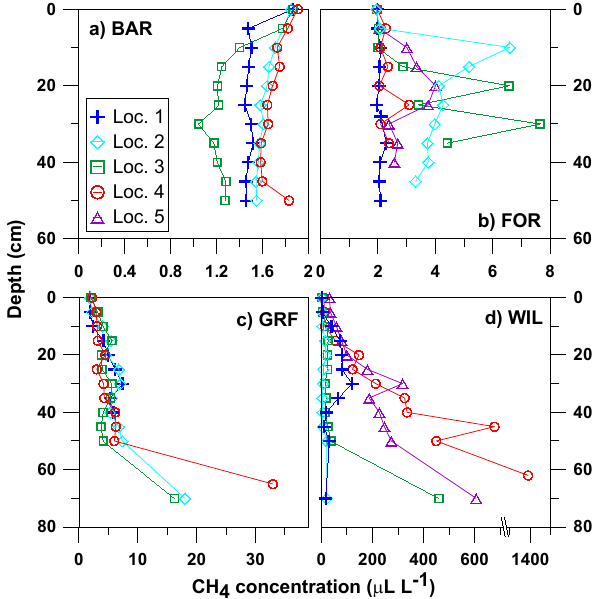
Fig. 1. Selection of measured soil-gas CH 4 concentration profiles representative for the different situations encountered. The legend in plot (a) applies to all subplots. Note the different scale in CH 4 concentrations for each